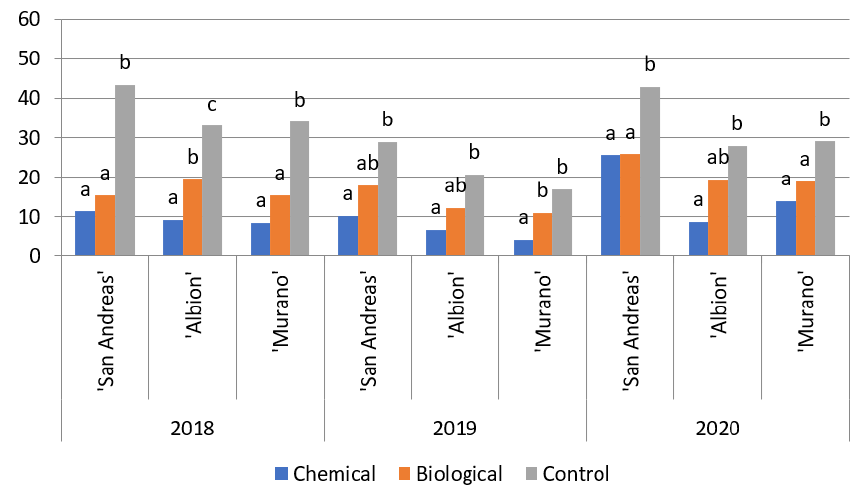
Figure 2. Percentage of fruit infected by Botrytis cinerea among fruit waste at harvest [%]. Bars on which the same letter follows within a cultivar for each year are not significantly different at p ≤ 0.05.